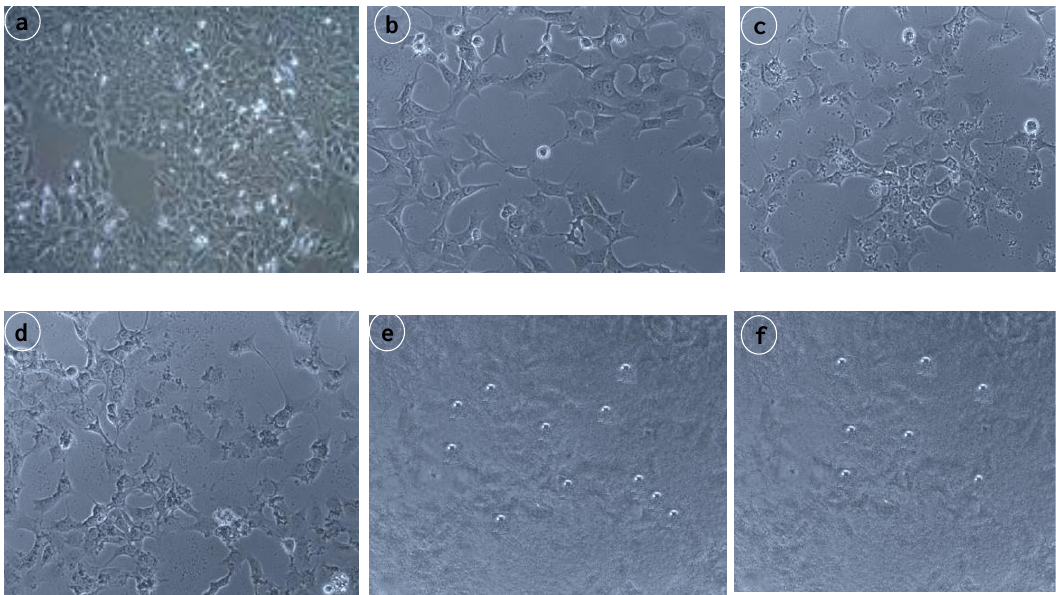
Figure 7. Morphological changes of the human breast cancer cell line MCF-7 after given treatment; ( a ) Control; ( b ) 20 μg /mL of cisplatin-SLNs; ( c ) 40 μg /mL of cisplatin-SLNs; ( d ) 60 μg /mL of cisplatin-SLNs; ( e ) 80 μg /mL of cisplatin-SLNs; ( f ) 100 μg /mL of cisplatin-SLNs.